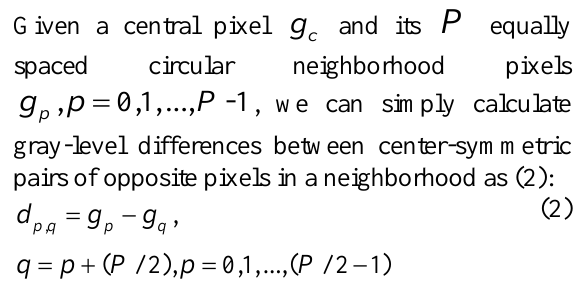
Figure 4. Pre-processing steps in our algorithm.